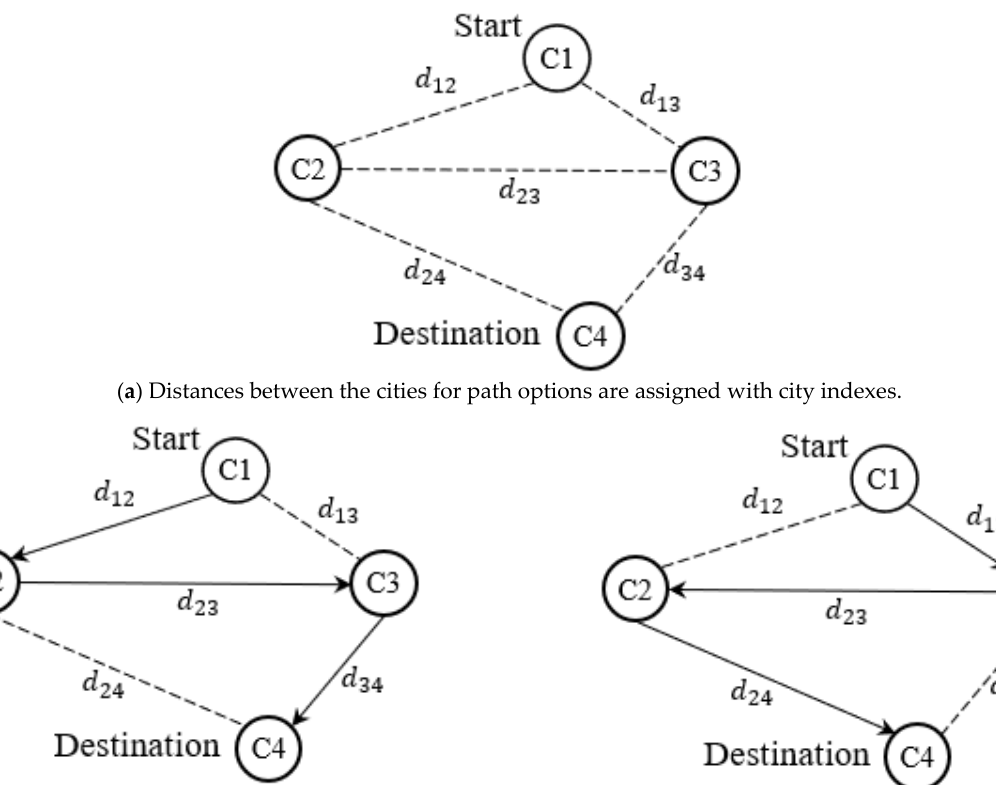
Figure 1. Adaptive visibility demonstration for optimal path selection from start city (C1) to desti-